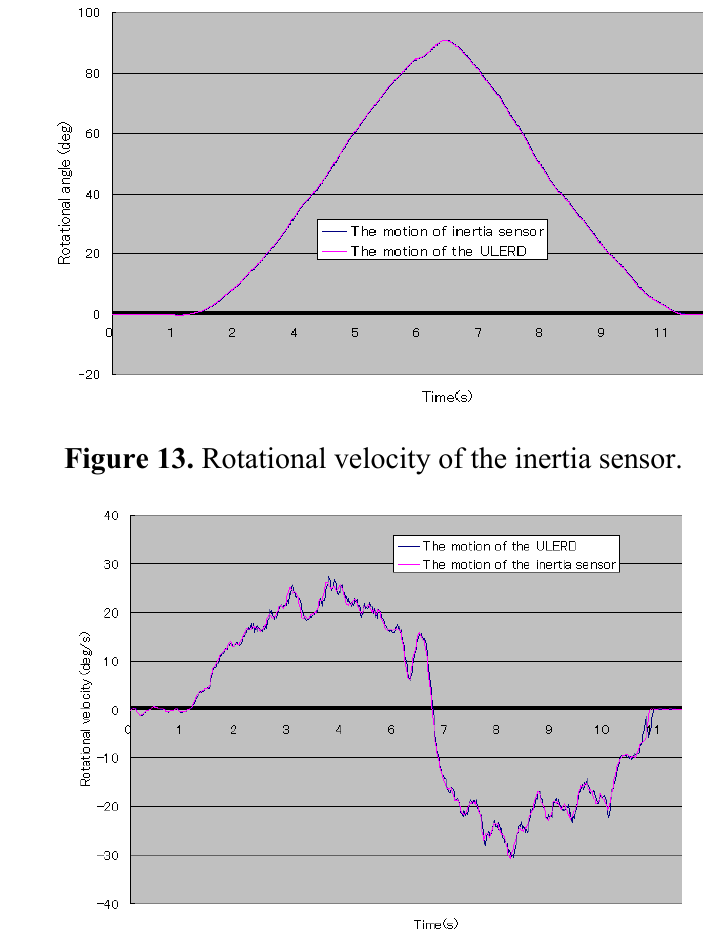
Figure 12. Rotational angle of the inertia sensor and the ULERD.